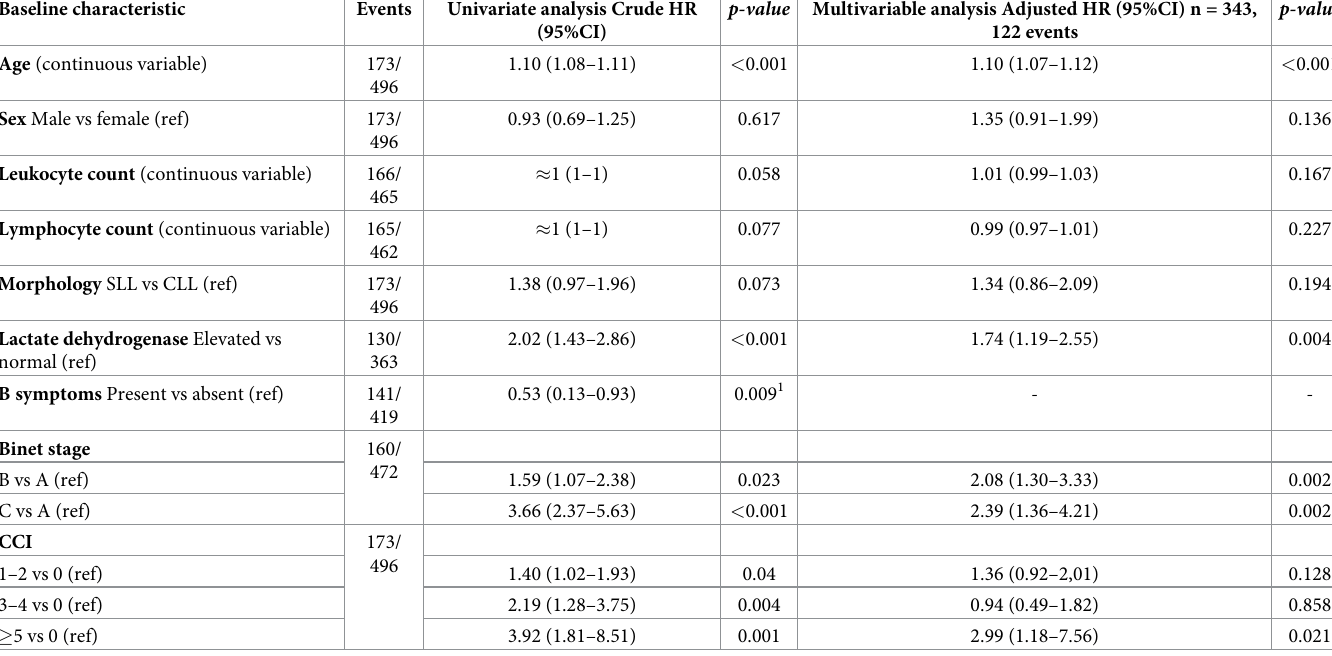
Table 3. Association between baseline characteristics and OS in CLL